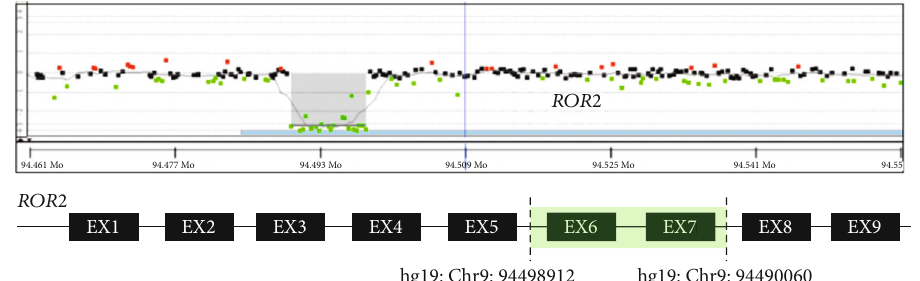
Figure 3: Results of aCGH for this patient revealed a homozygous deletion a ff ecting ROR2, encompassing exons 6 and 7 con fi rmed by Sanger